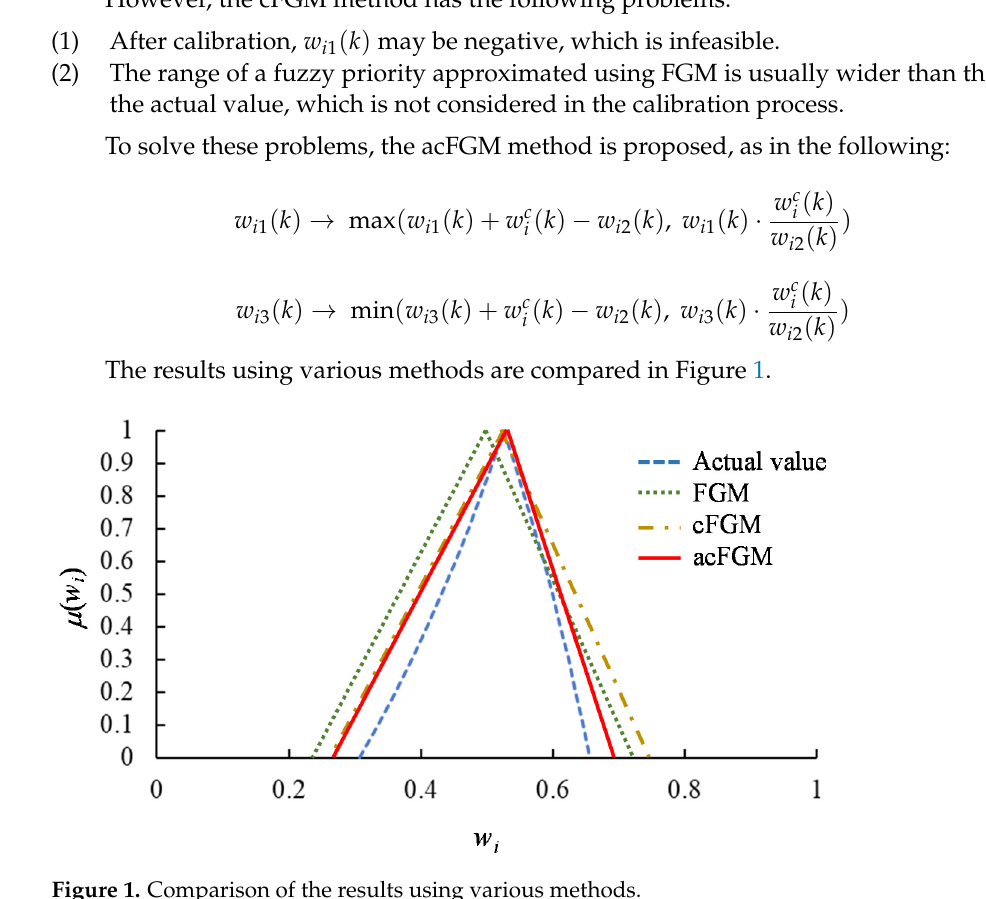
Figure 1. Comparison of the results using various methods.